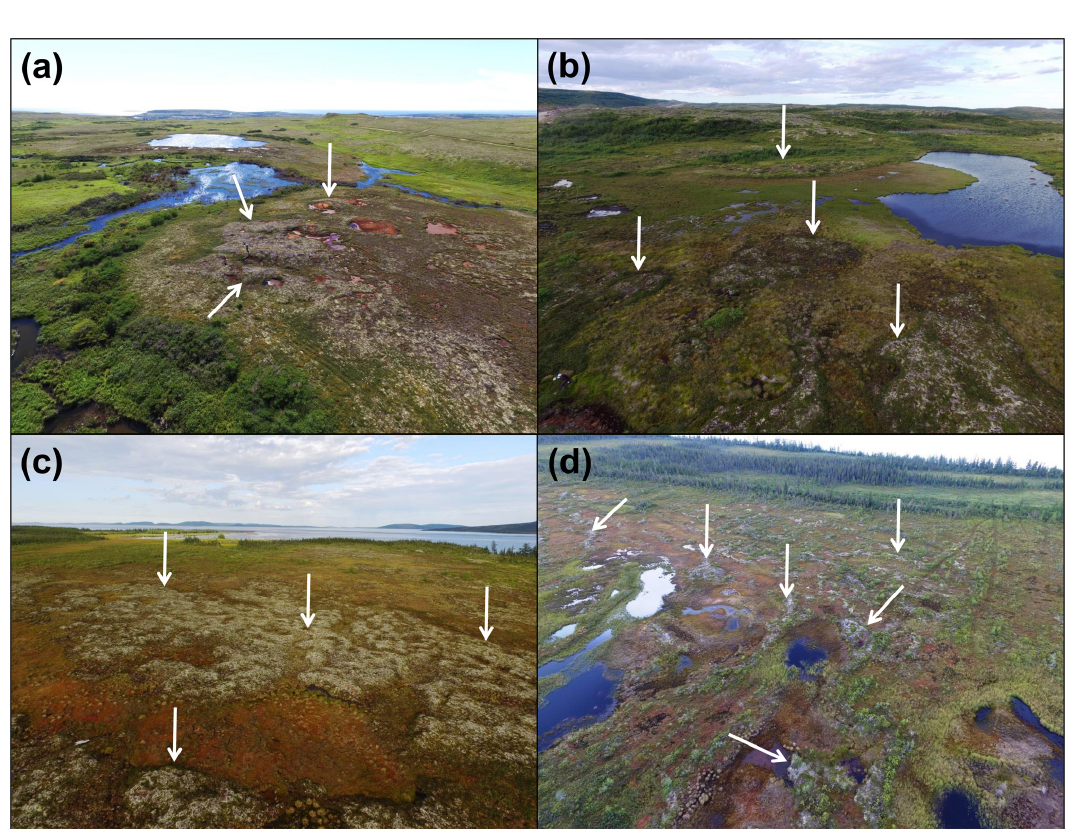
Figure 2. Low-altitude unmanned aerial vehicle (UAV) imagery of peatland permafrost sites at (a) Blanc-Sablon, QC; (b) Red Bay, NL; (c) Main Tickle, NL; and (d) Neveisik Island, NL. White arrows point to examples of permafrost-cored